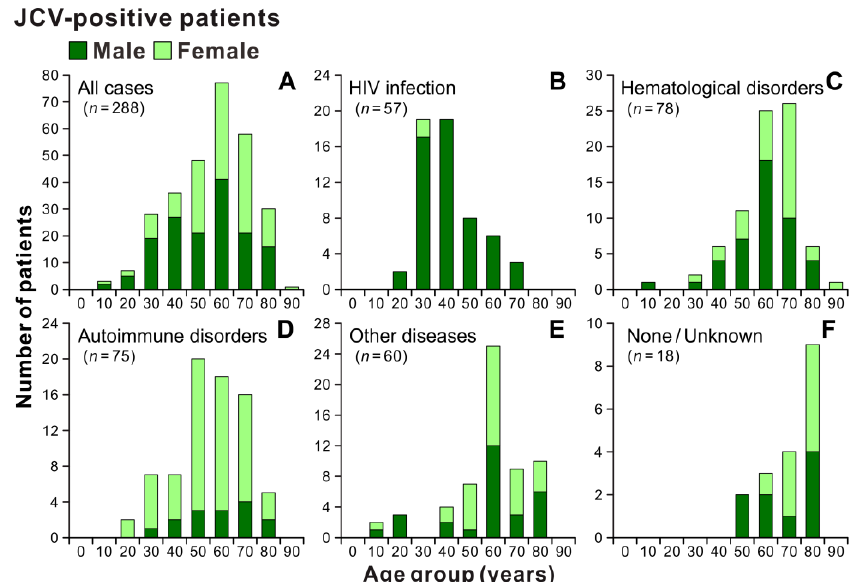
ral therapy. All percentages are rounded to two decimal places.